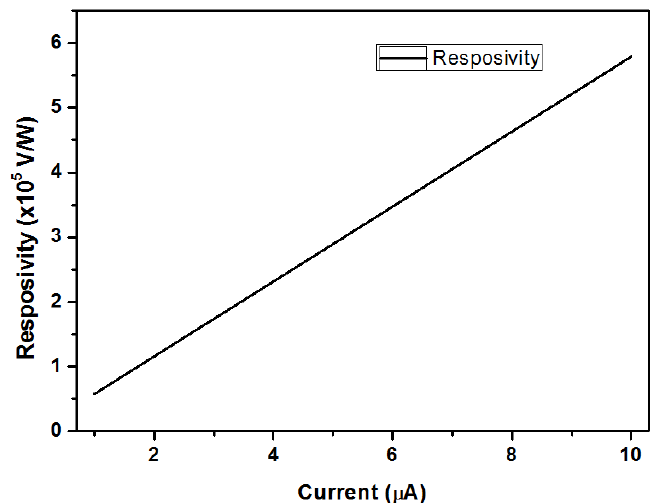
Figure 13. Calculated responsivity of the proposed protein microbolometer.